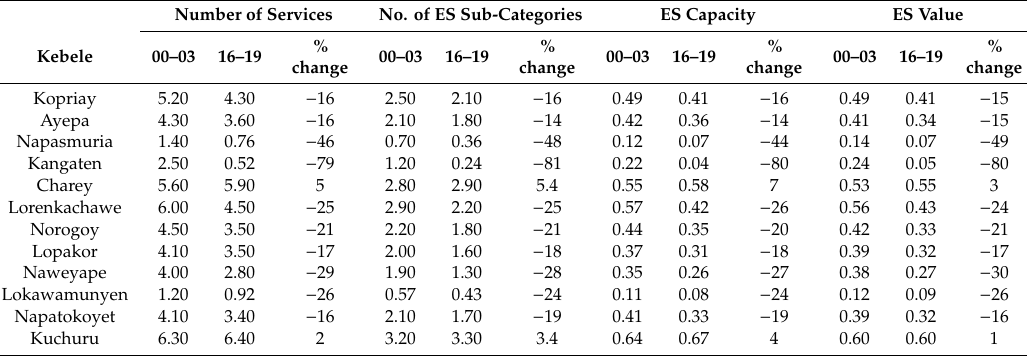
Table 7. Summary of provisioning Ecosystem Service (ES) metrics for kebeles in Nyangatom in 2000–2003 and 2016–2019, and the percentage change between these